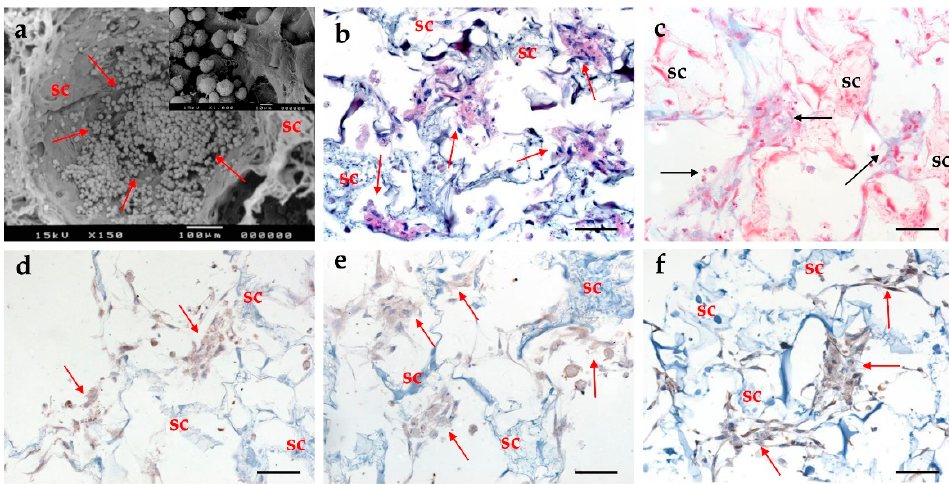
Figure 3. Morphological and histological analysis of the 3D cartilage model (10 differentiation days): ( a ) SEM micrograph showing round-shaped cells in a large pore of the scaffold. Lens shows the morphology of rounded cells; ( b ) H & E staining: cell nuclei are in blue-violet, cytoplasm is in pink; ( c ) Alcian blue pH 1 staining: sulphated GAGs are in cyan, cell nuclei are in red; ( d – f ) IHC analysis for: ( d ) Sox-9, ( e ) aggrecan, ( f ) collagen type II. Antigen expression is in brown, cell nuclei are in blue-violet. Sc = scaffold; red arrows = cells. ( b – f ) Scale bar = 50 μ m. Original magnification 400×.